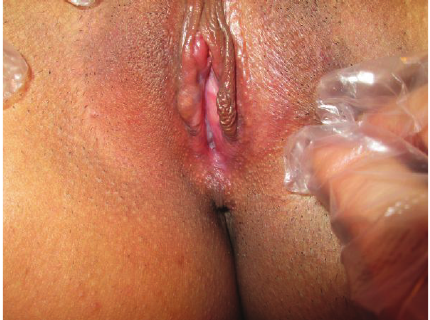
Figure 1: Complete fusion of the labia minora with obliteration of the vaginal introitus and urethral meatus.